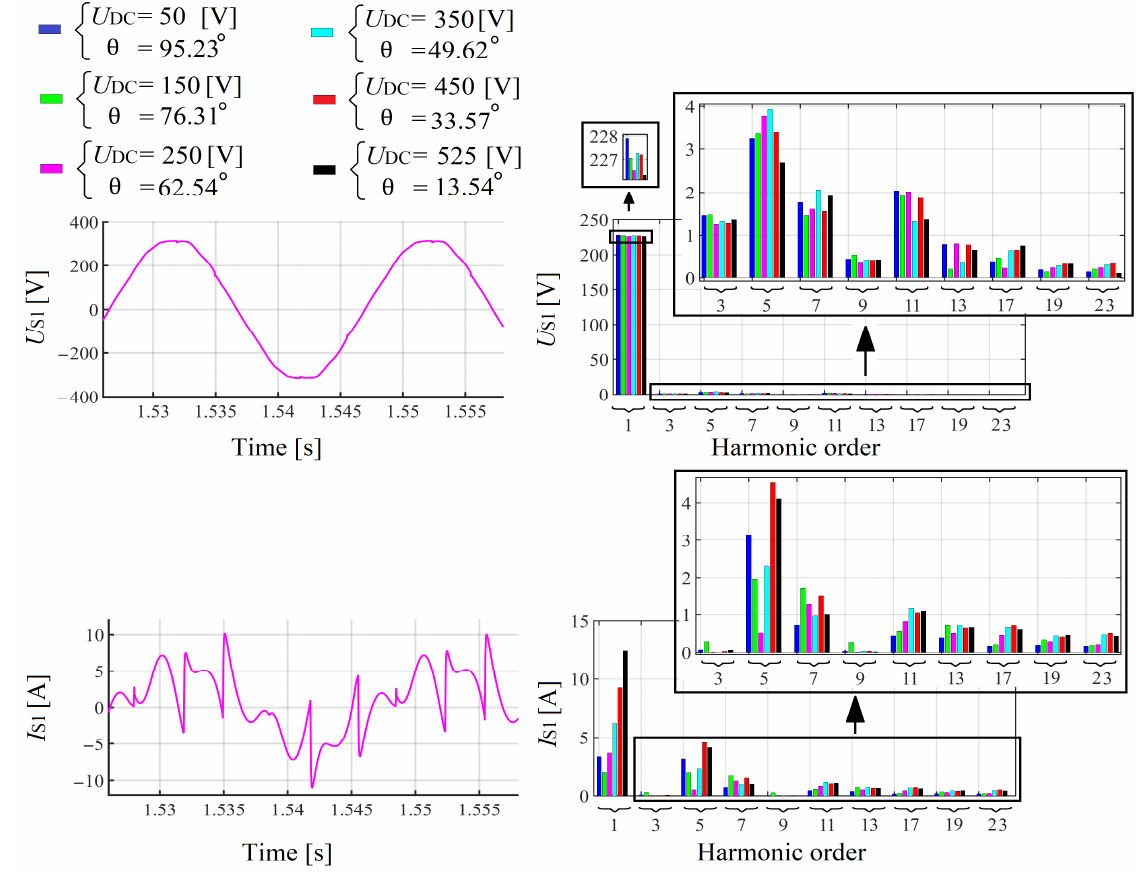
Figure 17. Grid voltage ( U S1 ) and current ( I S1 ) waveforms with their spectrums (after the filter con- nection).